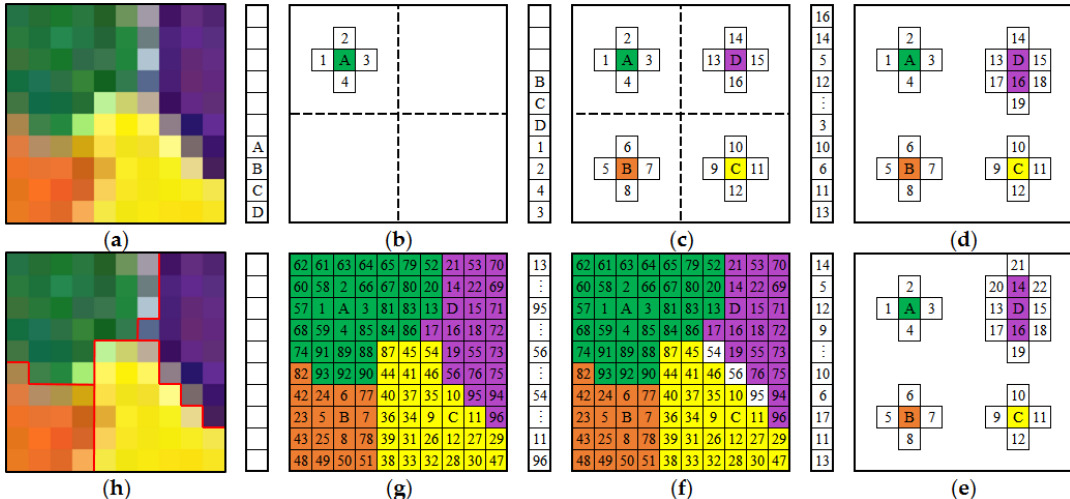
Figure 1. Dynamic segmentation procedure of simple non-iterative clustering (SNIC). ( a ) Input image; ( b – g ) execution of SNIC; ( h ) segmentation result. Among ( b ) to ( g ), each left column indicates the priority queue Q , in which the upmost element has the highest priority. The number in each pixel grid depicts the global order when it is inspected as a 4-neighbor element. Pixels with filled colors in label maps indicate that they have acquired labels corresponding to their nearest cluster centers. Note that the state of Q is one step earlier than the corresponding label map with pixel inspection and label assignment.